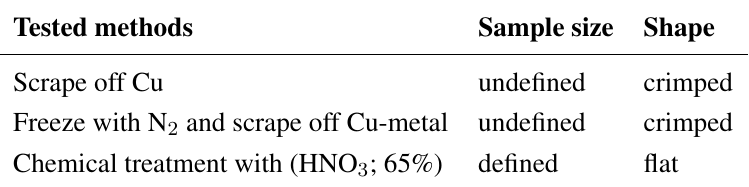
Table 1. Methods for the separation of the graphite from the copper